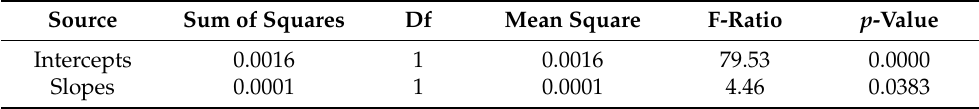
Figure 4. Soil lines for SOM5 and SOM15 soil units. NIR and Red values for DOY 49 in the period 2000 to 2019. Slope of linear regression indicates bare soil line (BSL) value which identifies the lowest NIR values for each level of red. Table 5. Statistical significance of bare soil lines (BSL) for SOM5 and